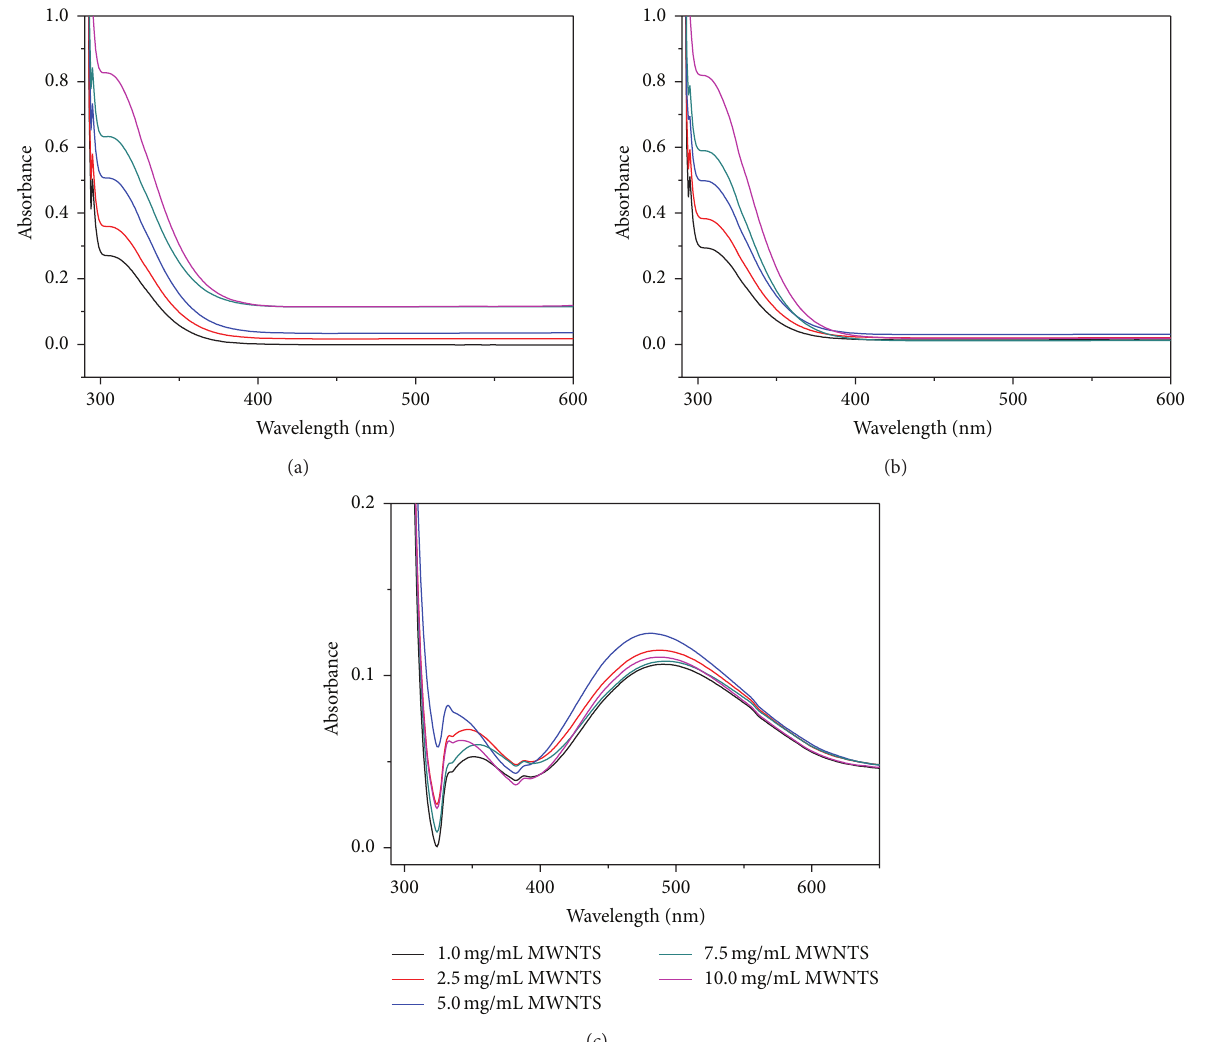
Figure1:UV-visspectraof(a)compositemixturesaftersonication,(b)compositemixturesaftersonication/centrifugation,and(c)composite thin films after electropolymerization for 5